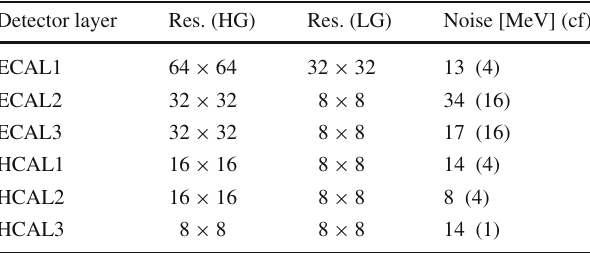
Table 2 Transverse segmentations for boththe HGand LGlayouts (the total transverse dimension is 125 × 125 cm 2 ) of the ECAL and HCAL individual layers and the corresponding simulated electronic noise per cell for the HG detector are shown. The noise for the LG detector is appropriately scaled up by a conversion factor (cf) while transiting from HG to LG detector Detector